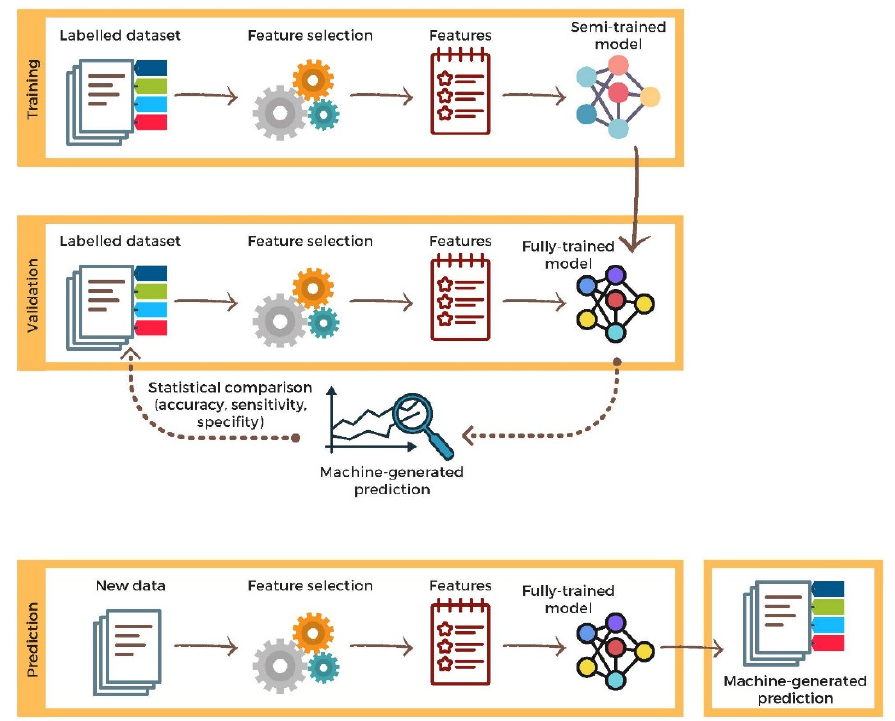
Figure 4. A brief description of supervised learning flowchart, including training, validation, and prediction.